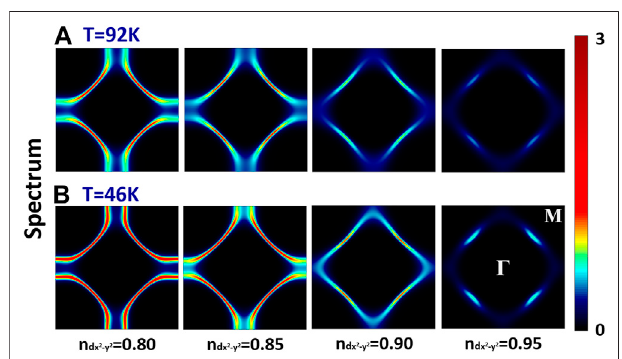
FIGURE6| D Γ A k -resolvedspectrumattheFermienergyfor T (cid:2) 0.02 t (cid:2) 92 K (A) and T (cid:2) 0.01 t (cid:2) 46 K (B) and four different dopings n d 3 d x 2 − y 2 band (left to right). From